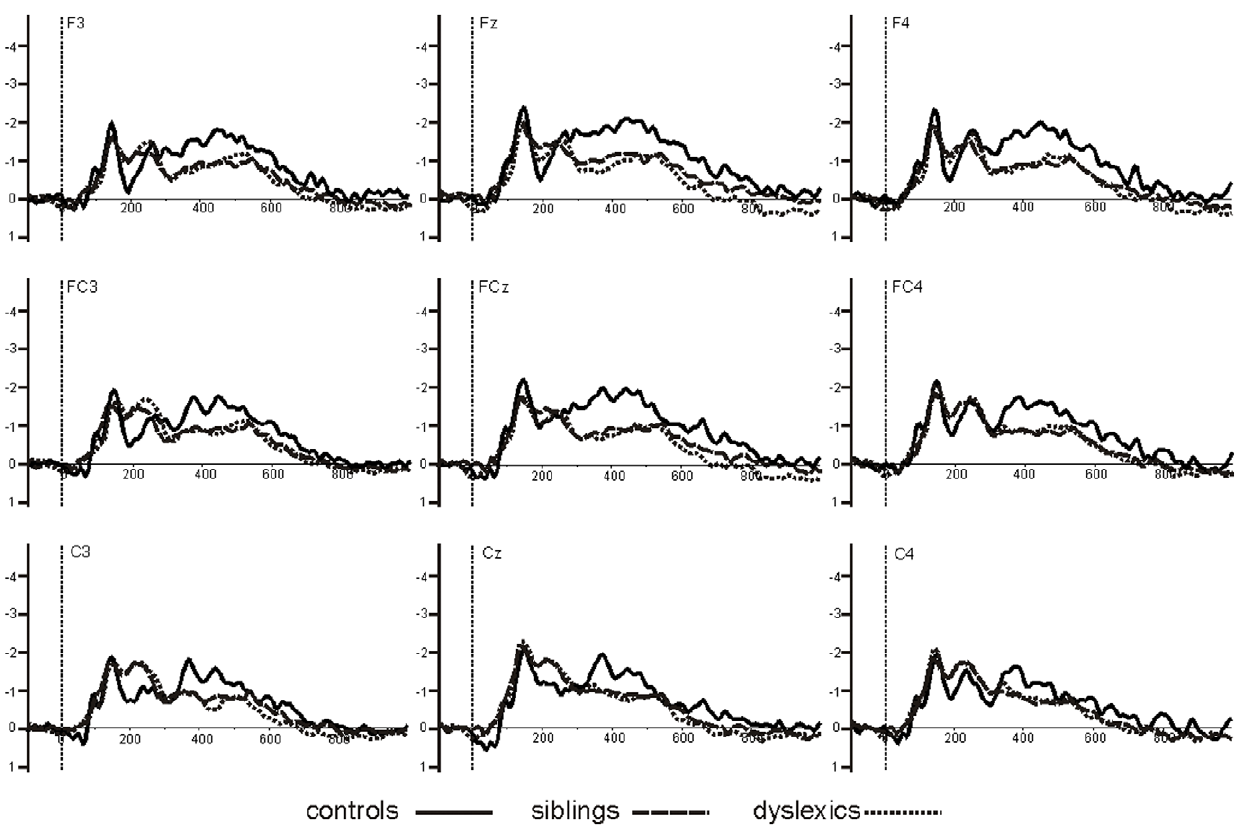
Figure 1. MMN1, MMN2, and late MMN for all 3 groups. MMN1, MMN2, and late MMN for dyslexic children (black line), unaffected siblings (dashed line), and unrelated controls (dotted line) at the nine fronto-central electrodes, giving the timeframes for the MMN1 (84–188 ms), MMN2 (188–300 ms), and late MMN (300–700 ms).